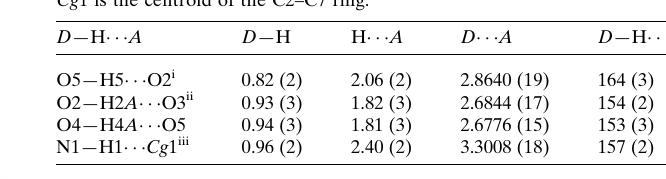
Table 1 Hydrogen-bond geometry (A˚ , (cid:4)